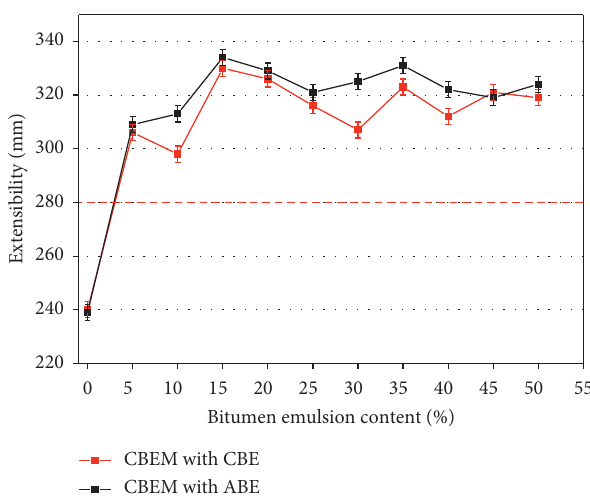
Figure 3: Influences of bitumen emulsion content on CBEM extensibility.